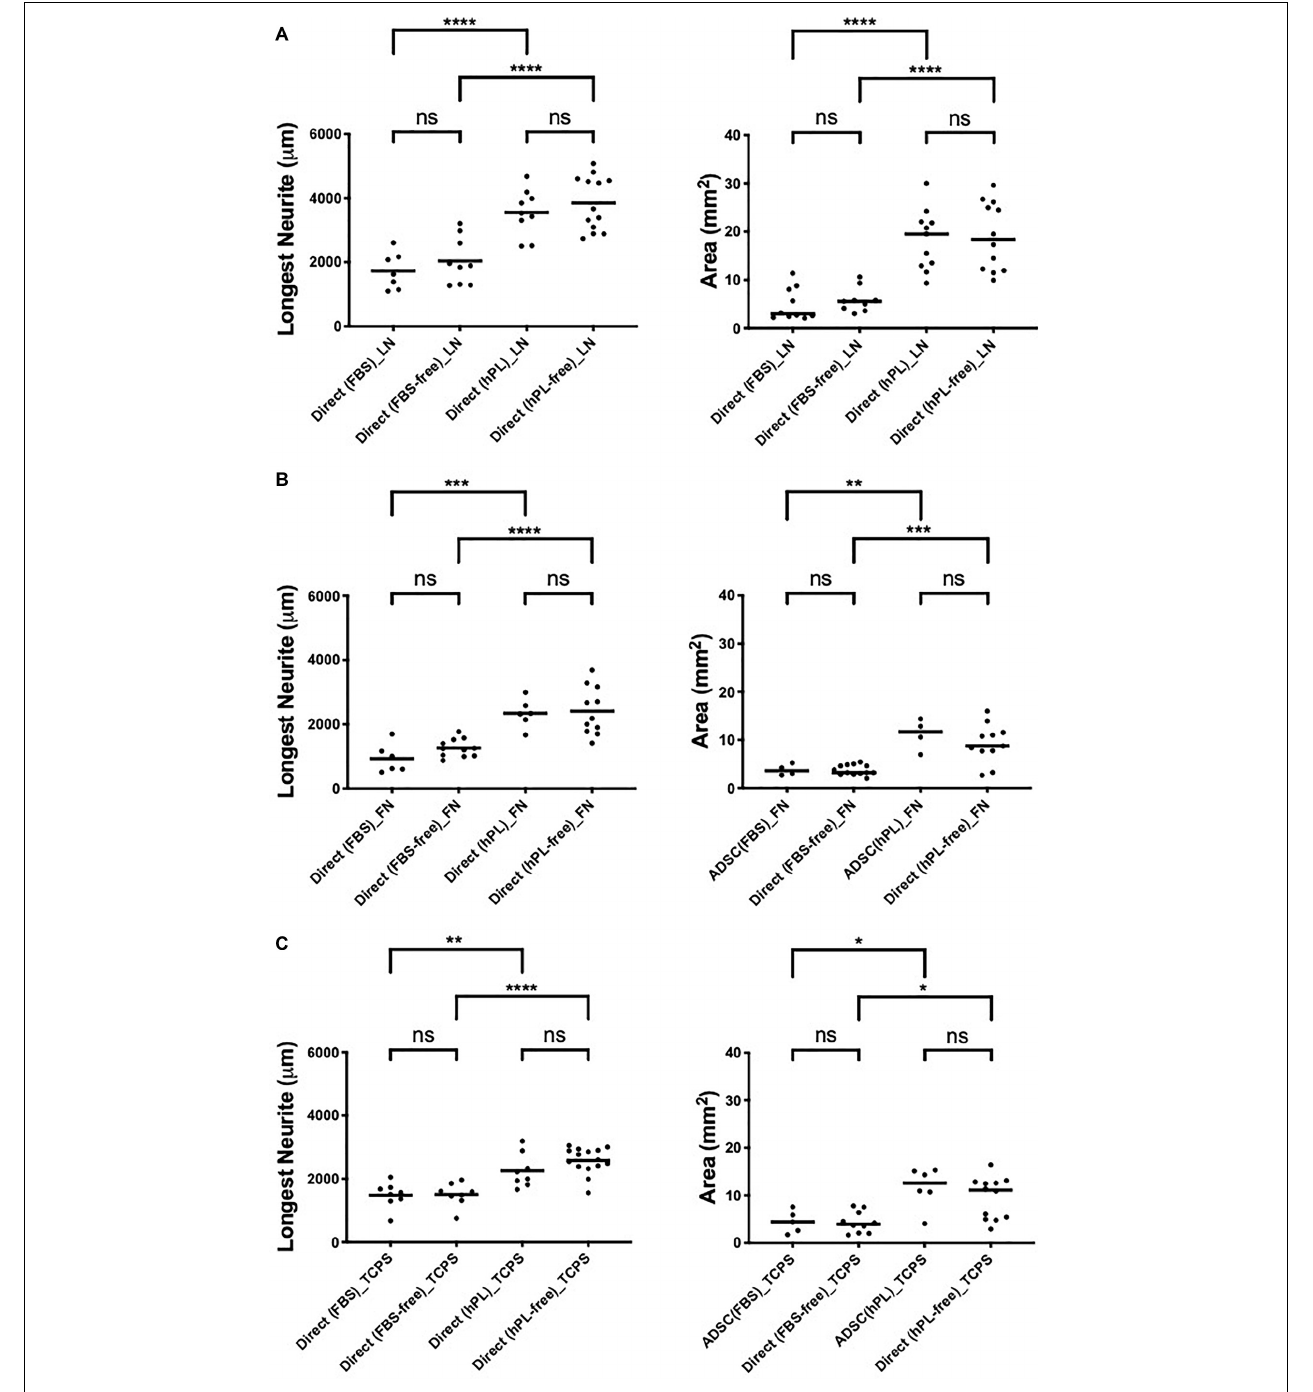
FIGURE A1 | hADSC maintain a neurotrophic effect despite serum deprivation in direct co-culture with primary neurons on LN (A) , FN (B) , and TCPS (C) . Longest neurite and axonal area of direct co-culture on LN (A) , FN (B) , and TCPS (C) . Three biological repeats and at least three technical replicates (DRG) were assessed. One-way ANOVA with Tukey’s multiple comparison tests was used for assessing statistical significance among the examined groups ( ∗ p < 0.05, ∗∗ p < 0.01, ∗∗∗ p < 0.001, ∗∗∗∗ p < 0.0001). The number of DRG tested corresponds to the number of dots for each condition in the graph.